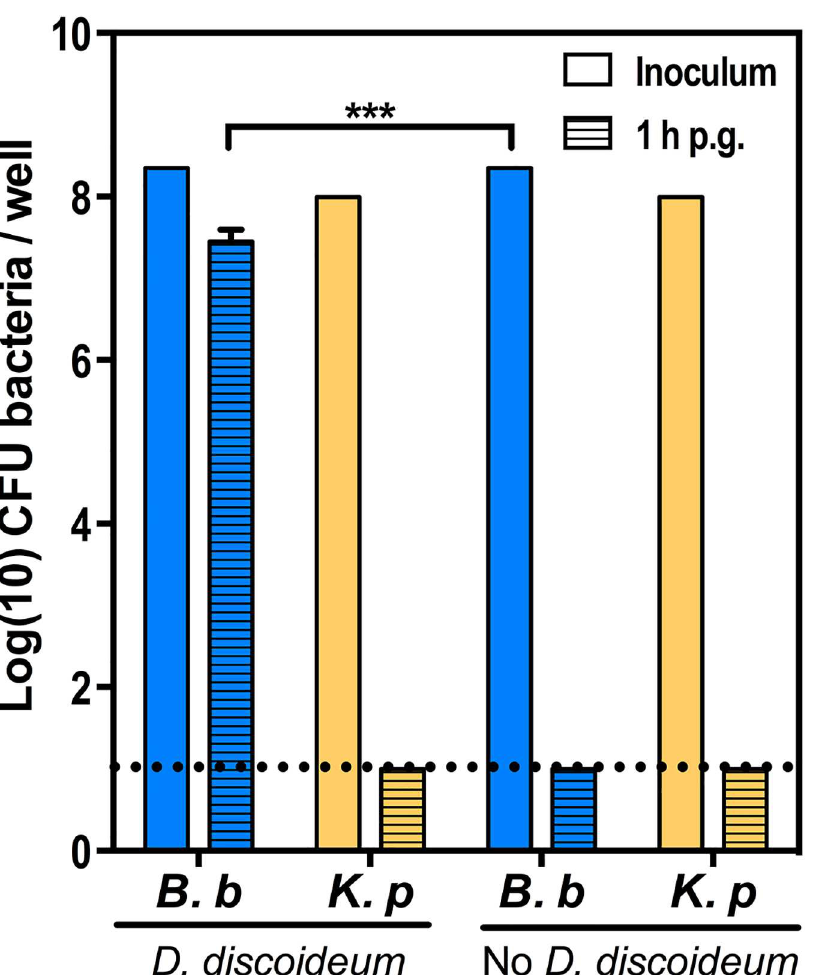
Fig 1. Intracellular survival in amoeba cells. B . bronchiseptica ( B . b , blue) or K . pneumoniae ( K . p , orange) were incubatedfor 1 h in HL/5 media containing D . discoideum at a multiplicityof infection (MOI) of 100 or in HL/5 media alone. Bars represent the initial inocula(open bars) and bacteria recovered 1 h post gentamicin (p.g.) application (hatched bars). *** denotes p < 0.00005. The dotted line indicatesthe limit of detection. CFU, colony forming unit. For further details, please see S1